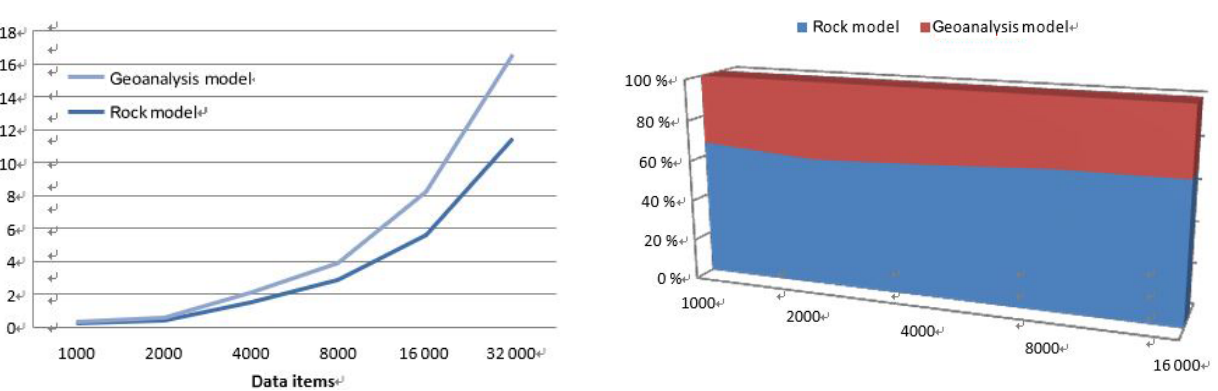
Figure 7. Time spent on data insert operations with increasing amounts of data.